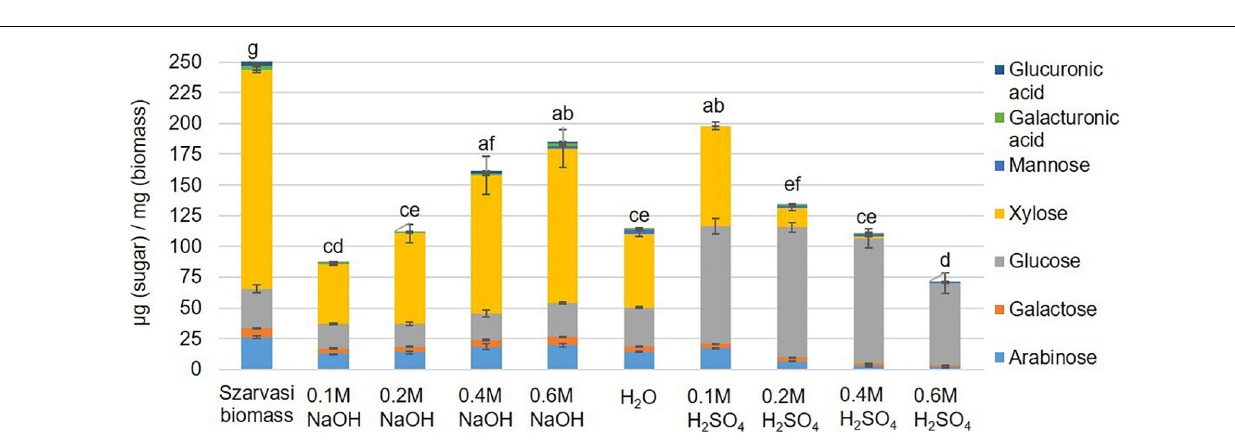
Frontiers in Plant Science |